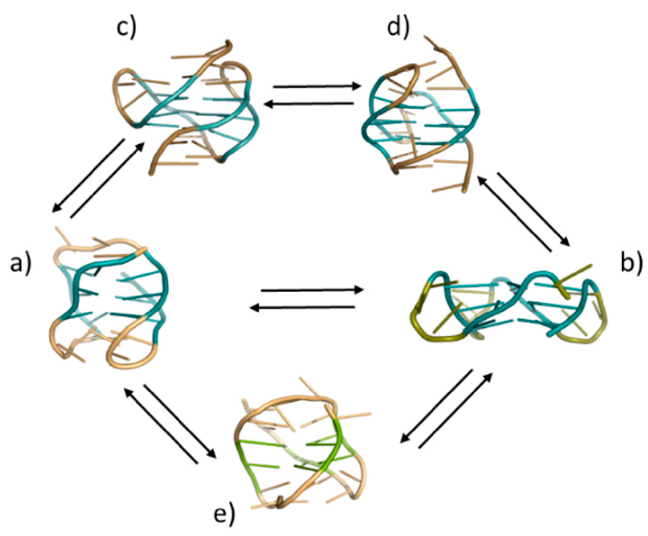
Figure 1. Overview of the solved G4 arrangements of telomeric repeats: ( a ) antiparallel (PDB 143D); ( b ) parallel (PDB 1KF1); ( c ) hybrid 1 (PDB 2HY9); ( d ) hybrid 2 (PDB 2JPZ); and ( e ) two-tetrads (PDB 2KKA).